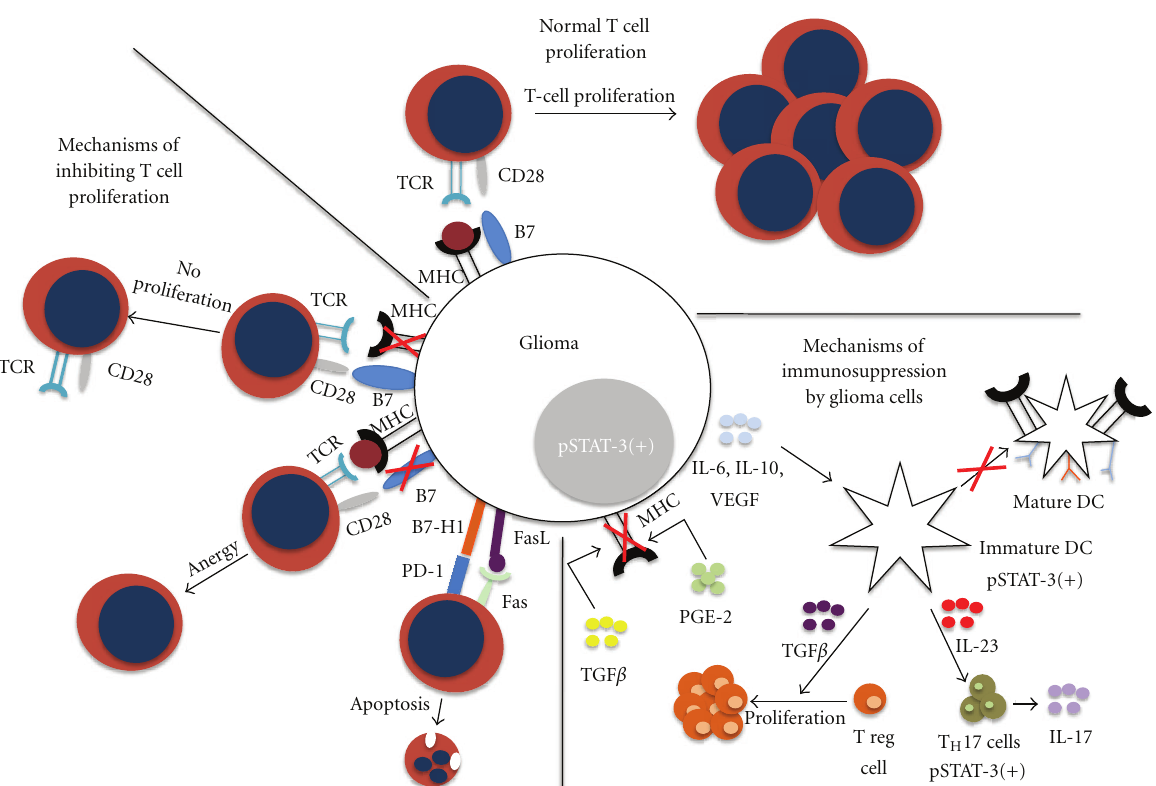
Figure 1: Normal T cell proliferation and mechanisms of glioma cell immunoresistance. (From top moving clockwise) Normal T cell proliferation: tumor cell antigens are presented by MHC and costimulatory molecules. Mechanisms of immunosuppression: glioma cells secrete factors leading to an immunosuppressive tumor microenvironment. TGFB and PGE-2 downregulate the expression of MHC, restricting antigen presentation and T cell proliferation. IL-6. IL-10 and VEGF are potent STAT-3 activators, leading to the proliferation of immature DCs that are not able to function as APCs. These immature DCs also secrete TGFB which aid in the proliferation of immunosuppressive Treg cells and STAT-3 positive TH17 cells. Mechanisms of inhibiting T cell proliferation: glioma cells downregulate MHC on their surface leading to the decreased antigen presentation and decreased T cell proliferation. Downregulation of B7 works via a similar mechanism in that the costimulatory signal is lost preventing T cell proliferation. Increased expression of B7-H1 and FasL act as proapoptotic signals for T